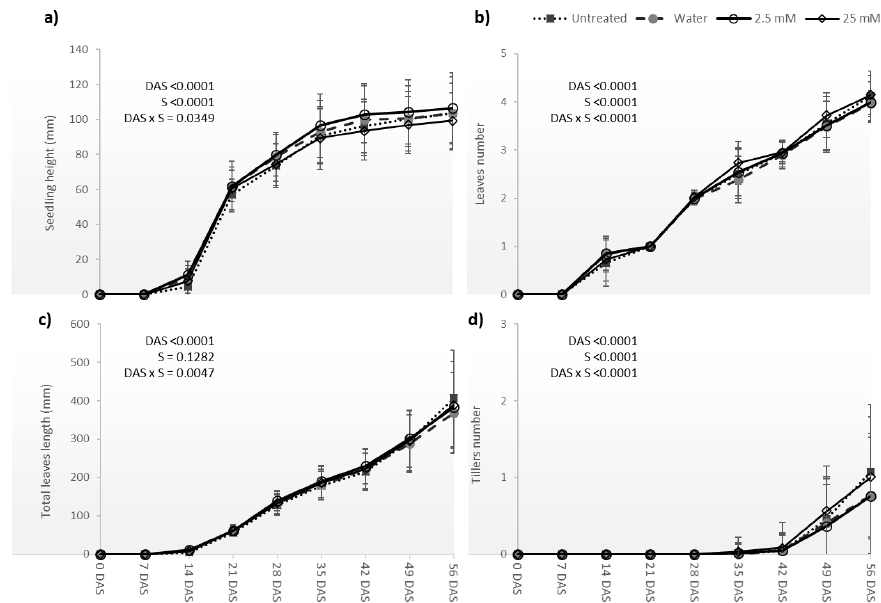
Figure 5. Seedling height ( a ), leaves number ( b ), total leaves length ( c ) and tillers number ( d ) of wheat seedlings for the four Se soaking treatments (SP) during the first 56 days after sowing (DAS). Values are means ± standard errors ( n = 80). Two-away ANOVA p -values for DAS, S and interaction DAS × S were shown for each parameter. Complementary information is shown in Supplementary Table S2.